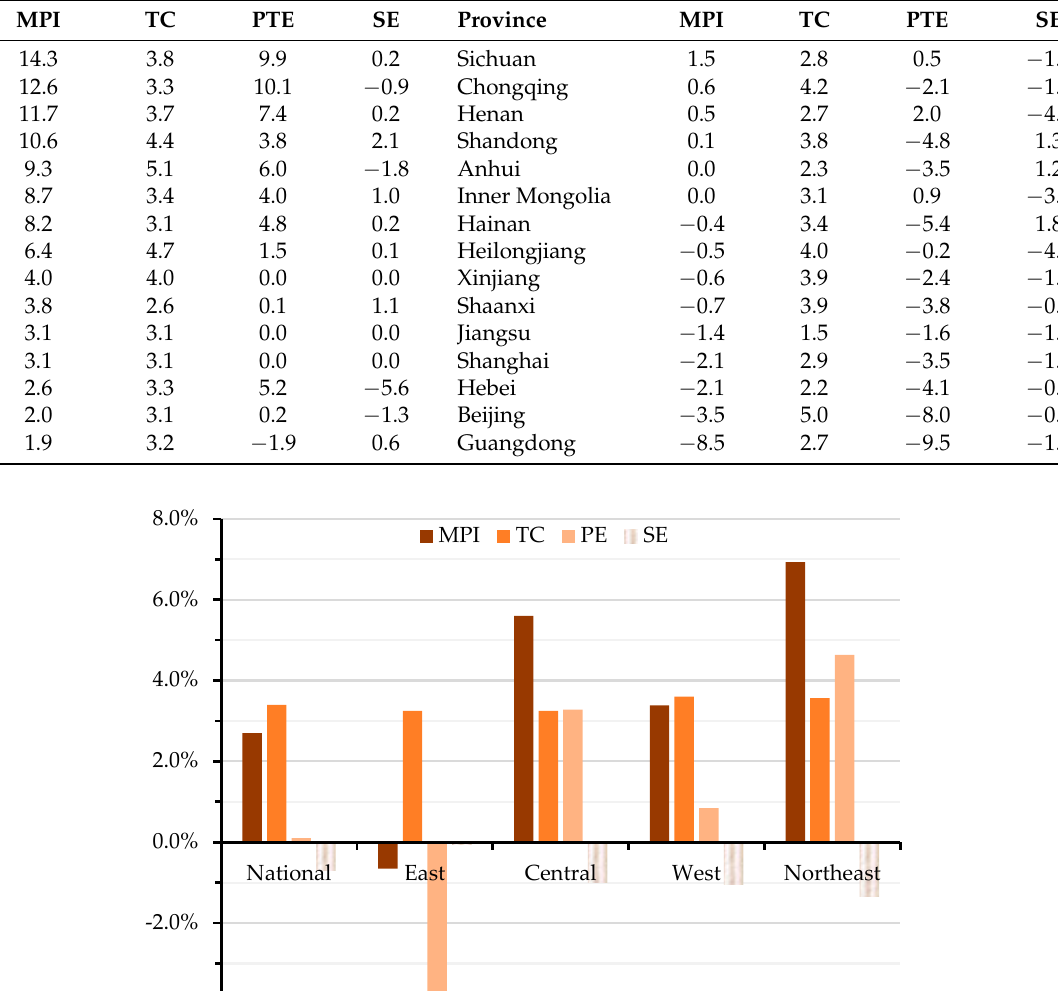
Table 4. Annual growth rate of MPI, TC, PTE, SE in 30 provinces of China.